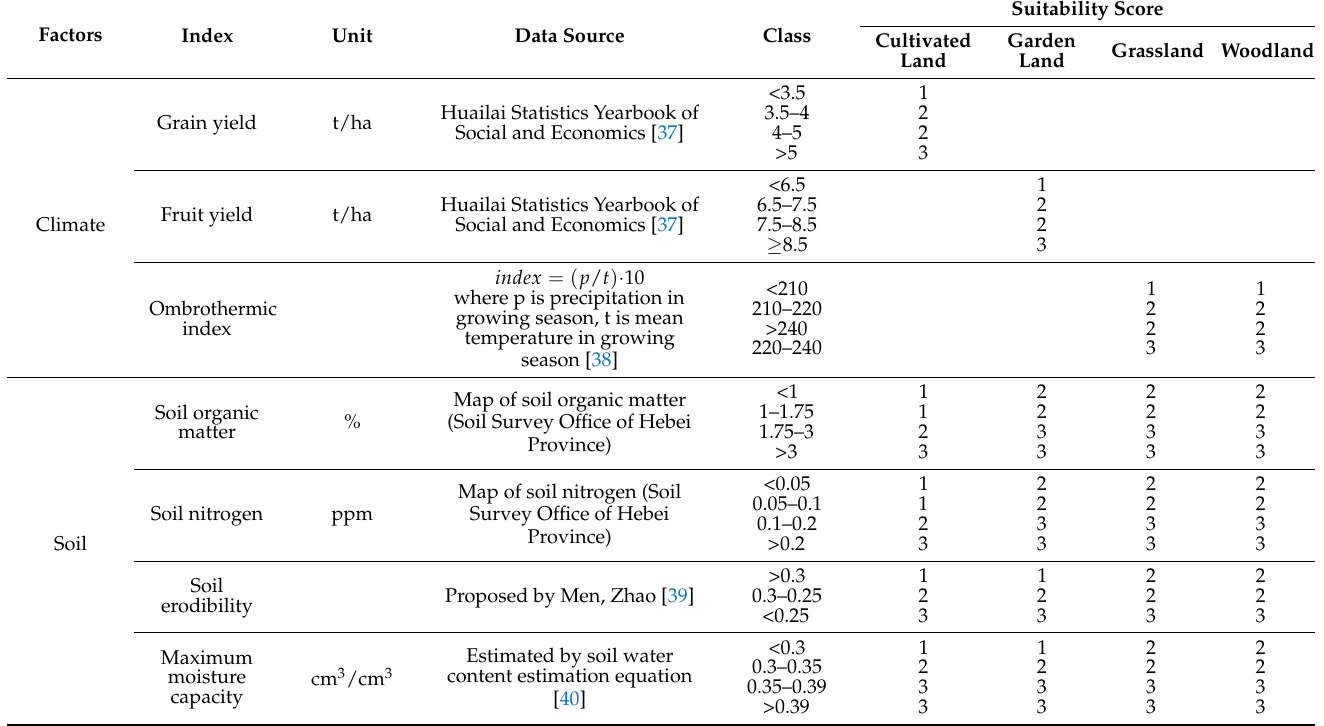
Table 4. Suitability evaluation factors and scores of four agricultural lands in the